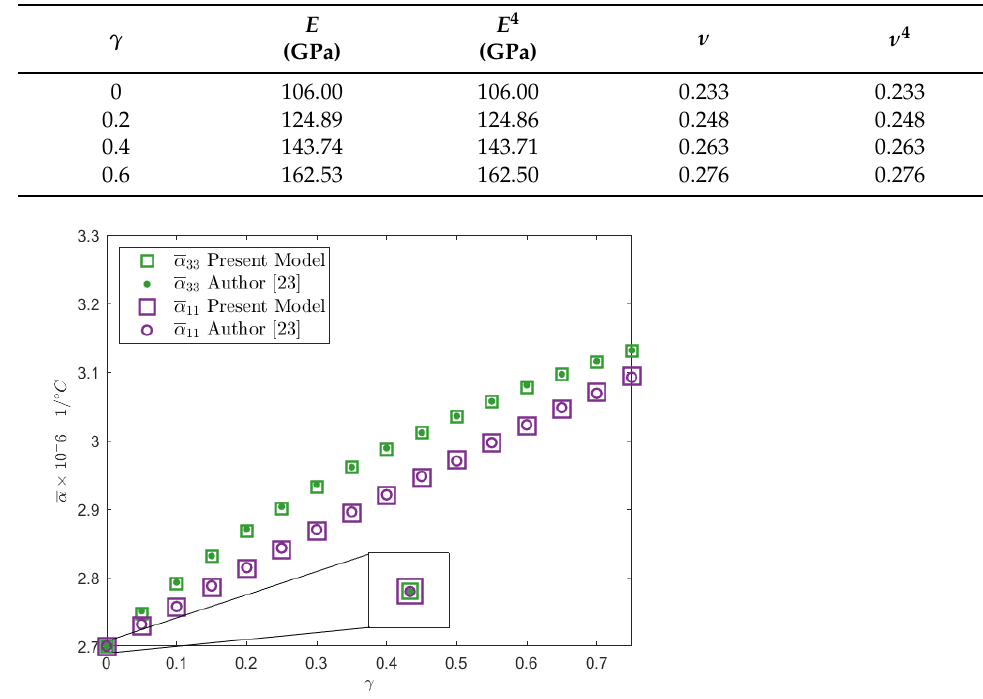
Table 4. Young’s modulus ( E 4 ) and Poisson’s ratio ( ν 4 ) for the Nicalon/BMAS composite material calculated by using the linear FEM approximation and those reported in [23].